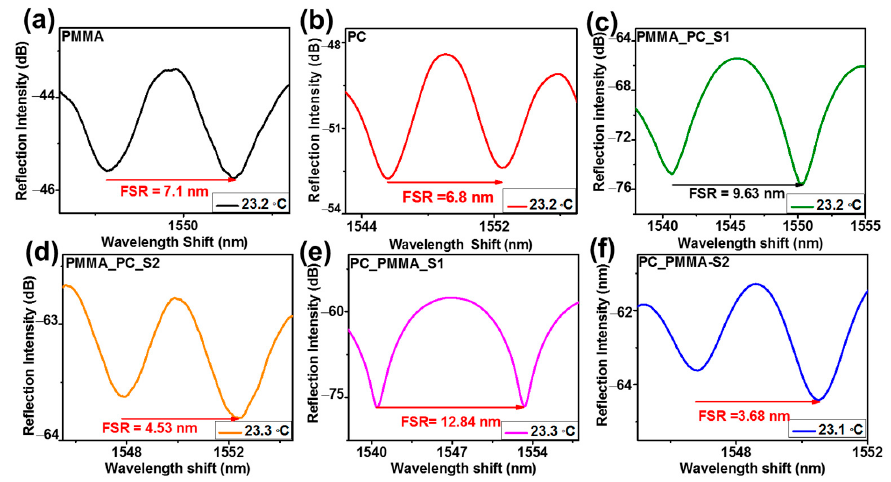
Figure 5. Reflected interference pattern of invented SPFPI ( a ) PMMA and ( b ) PC, DPFPI ( c )